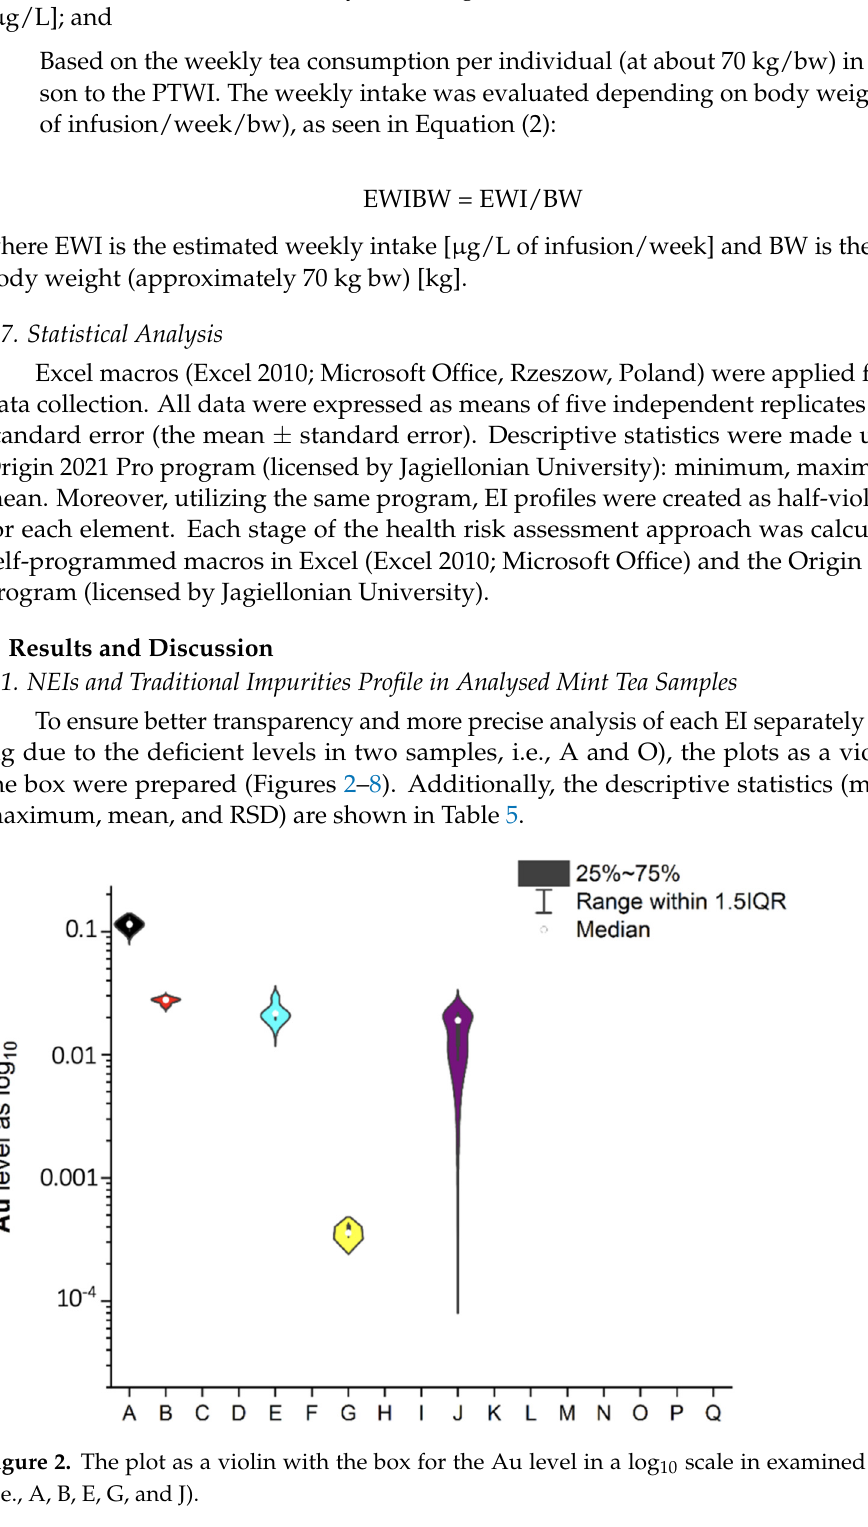
Figure 3. The plot as a violin with the box for the Cs level (µg/L) in the examined products (A–Q).